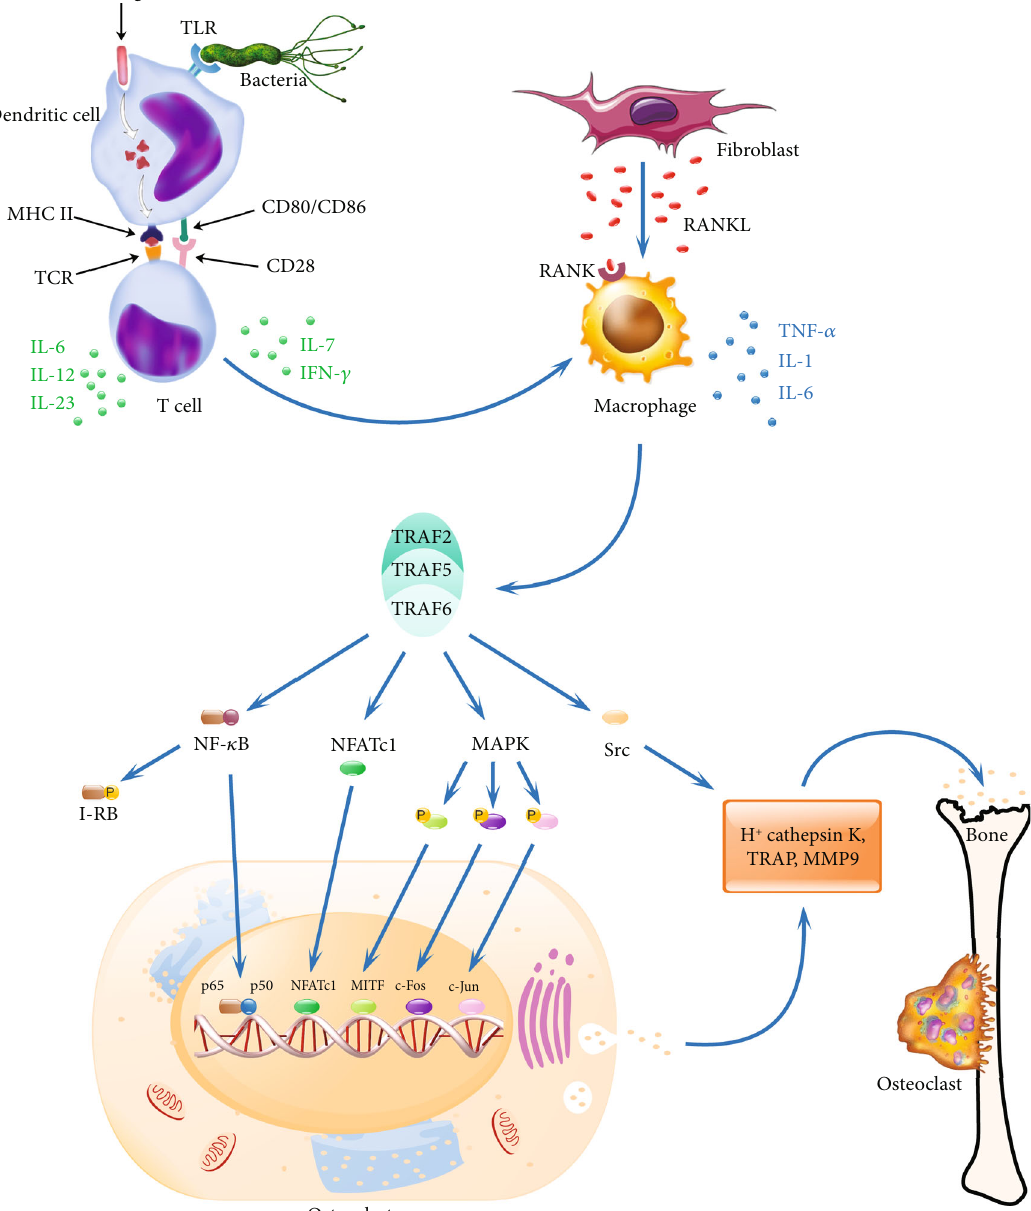
Figure 3: Signaling pathways in osteoclast activation. During RA pathogenesis, antigen-presenting cells after uptake of an autoantigen or pathogenic molecules process and present antigenic determinants on their cell surface in conjunction with arthritis-permissible HLA/MHC class II molecules, which activate di ff erentiation of T cells into di ff erent subphenotypes. The activated T cells secrete various cytokines like IL-6, IL-7, IL-10, IL-12, IL-17, IL-23, and IFN- γ . These cytokines modulate macrophages to secrete various pro- and/or anti-in fl ammatory cytokines and other in fl ammatory mediators. Upon exposure to the in fl ammatory cytokines, fi broblast-like synoviocytes express RANKL, which binds with its receptor (RANK) present on the cell surface of activated macrophages initiating the RANK/RANKL pathway through TRAF 2, 5, and 6 proteins, which leads to the activation of downstream NF- κ B, MAPK, NFATc1, and Src signaling cascades. These factors after translocation initiate the expression of genes like TRAP, CtsK, and MMP-9 in the nucleus, which promote osteoclastogenesis and bone resorption. TLR: toll-like receptor; TCR: T cell receptor; CtsK: cathepsin K; I- κ B: inhibitor of the NF- κ B transcription factor; IL: interleukin; IFN- γ : interferon gamma; MAPK: mitogen-activated protein kinase; MHC II: major histocompatibility complex II; MITF: microphthalmia-associated transcription factor; MMP 9: matrix metalloproteinase 9; NFATc1: nuclear factor of activated T cells, calcineurin-dependent 1; NF- κ B: nuclear factor kappa B; p50 and p65: REL-associated proteins (also called NF- κ B1 and RelA) involved in NF- κ B heterodimer formation and nuclear translocation and activation; RANK: receptor activator of nuclear factor- κ B; RANKL: receptor activator of nuclear factor κ B ligand; Src: intracellular non-receptor tyrosine kinase; TRAF: TNF receptor-associated factor; TRAP: tartrate-resistant acid phosphatase. c-Jun and c-Fos form the early response transcription factor,